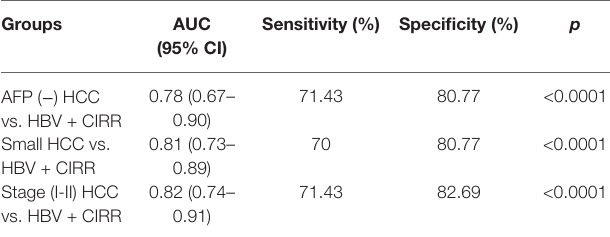
TABLE 4 | The diagnostic performance of has_circ_0028861 for the detection of AFP-negative, small and early-stage HCC.